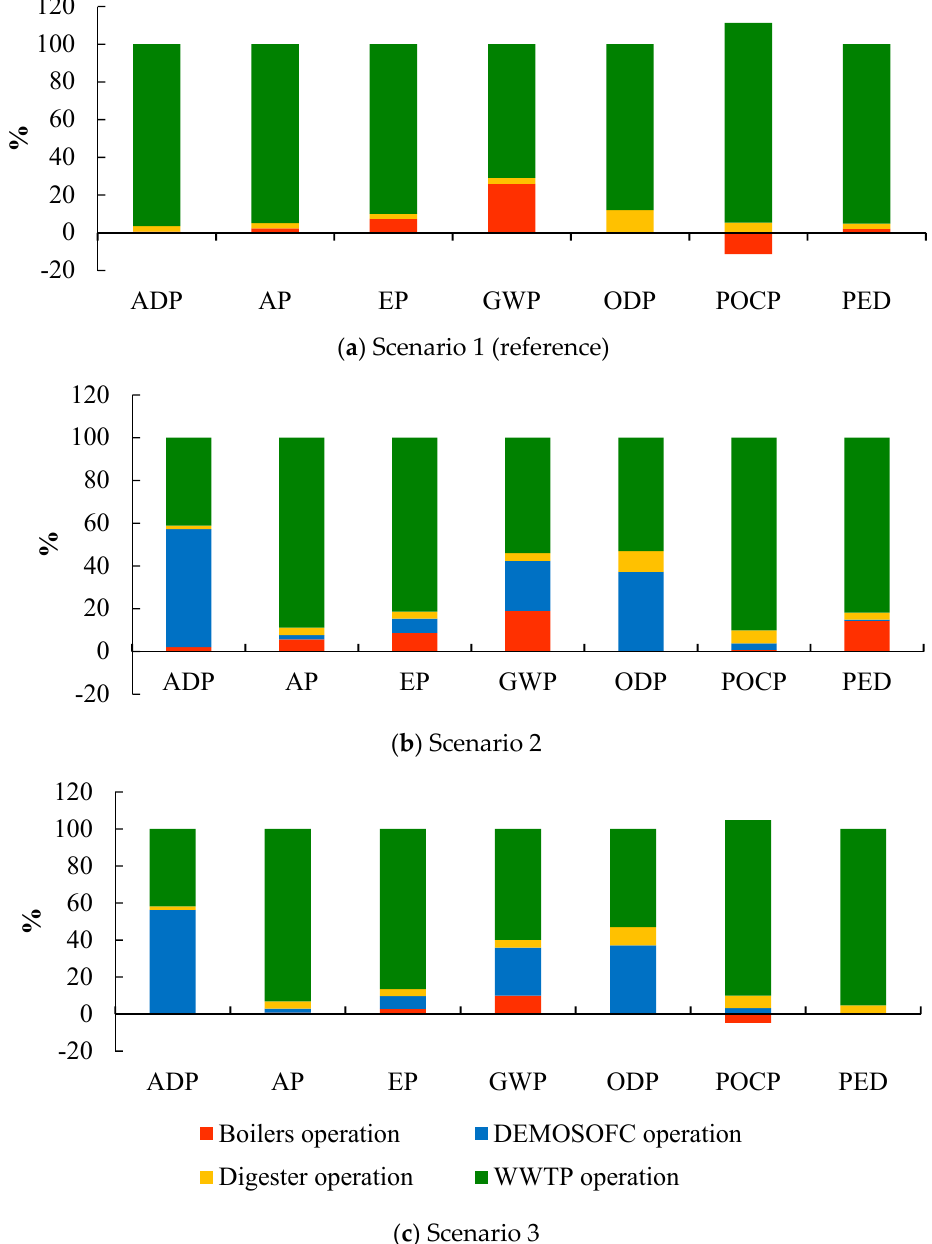
Figure 7. LCIA profile of the three scenarios (ADP: Abiotic Depletion Potential of elements, AP: Acidification Potential, EP : Eutrophication Potential, GWP: Global Warming Potential, ODP: Ozone Depletion Potential, PED: Primary Energy Demand, POCP: Photochemical Ozone Creation Potential).